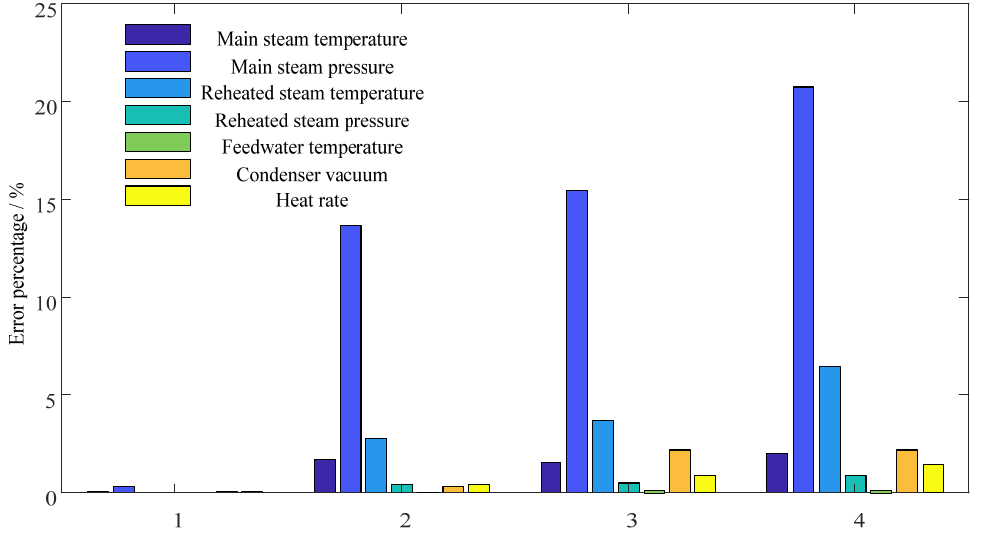
Figure 9. The error percentage histogram of parameters in four groups.